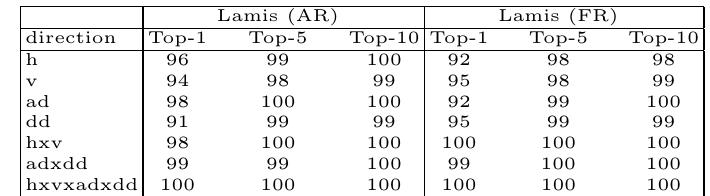
Table 2. Classification results using the VLAD encoding system with a number of clusters (k = 128) and several